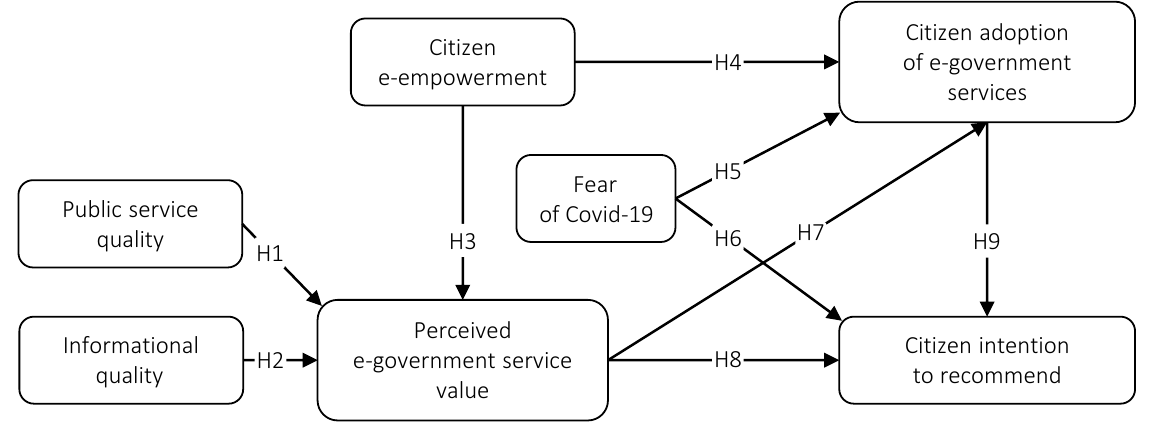
Figure 1. Research